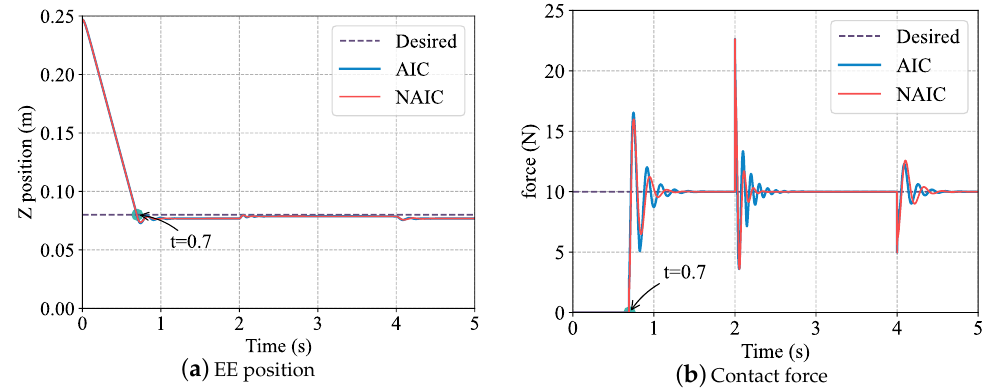
Figure 3. Force tracking with changing environment stiffness. ( a ) Z position. ( b ) Contact force tracking. At t = 2 s, the flat surface stiffness increases, and the error between the robot and the surface position is reduced to track the desired